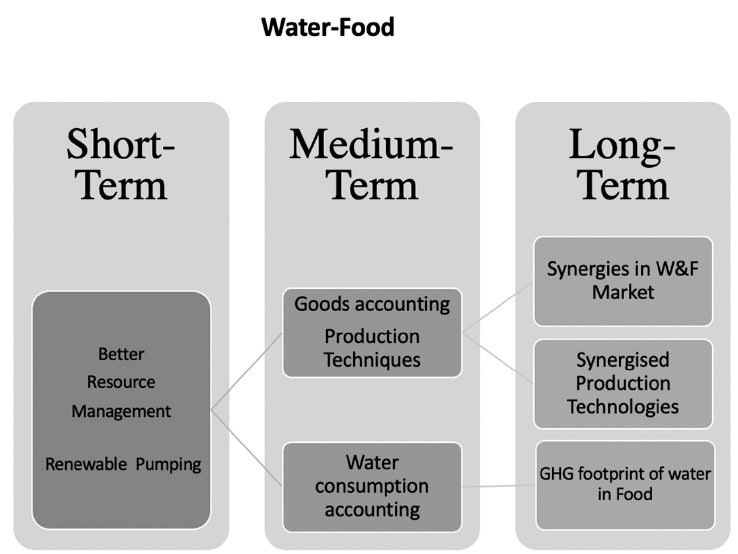
Energies 2022 , 15 , x FOR PEER REVIEW Figure 5. Sustainable environment approach for WEF systems management. Figure 5. Sustainable environment approach for WEF systems management.